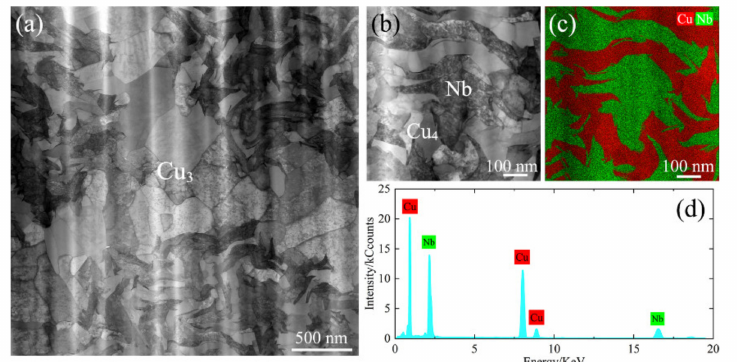
Figure 8. Transverse sectional HAADF-STEM of 85 4 Cu-Nb microcomposite wire, ( a ) Cu 3 +Cu 4 +Nb region, ( b ) Cu 4 +Nb region, ( c ) EDS elemental mapping, and ( d ) EDS spectrum of ( b